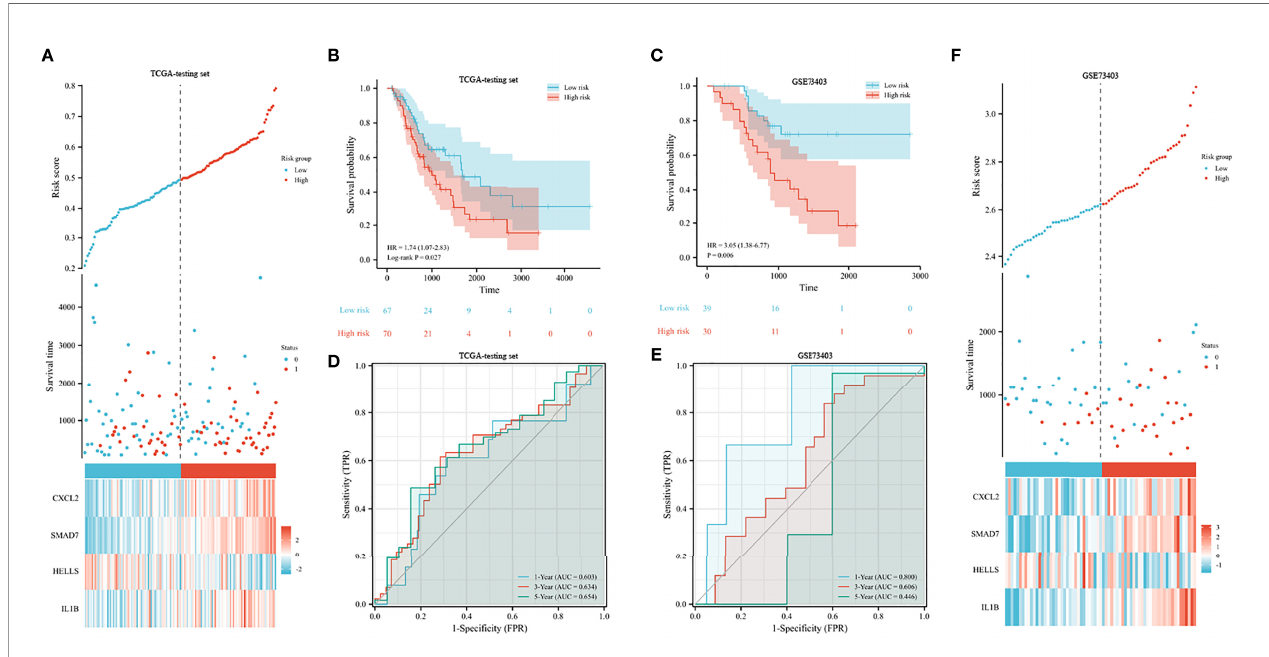
FIGURE 6 | Validation of prognostic signature for LUSC. (A, B) Risk plot (A) and overall survival (B) in the TCGA testing set. (C) Overall survival analysis in the GEO validation set. (D, E) The receiver operating curve for overall survival in the TCGA testing set (D) and GEO validation set (E) . (F) Risk plot in the GEO validation set.